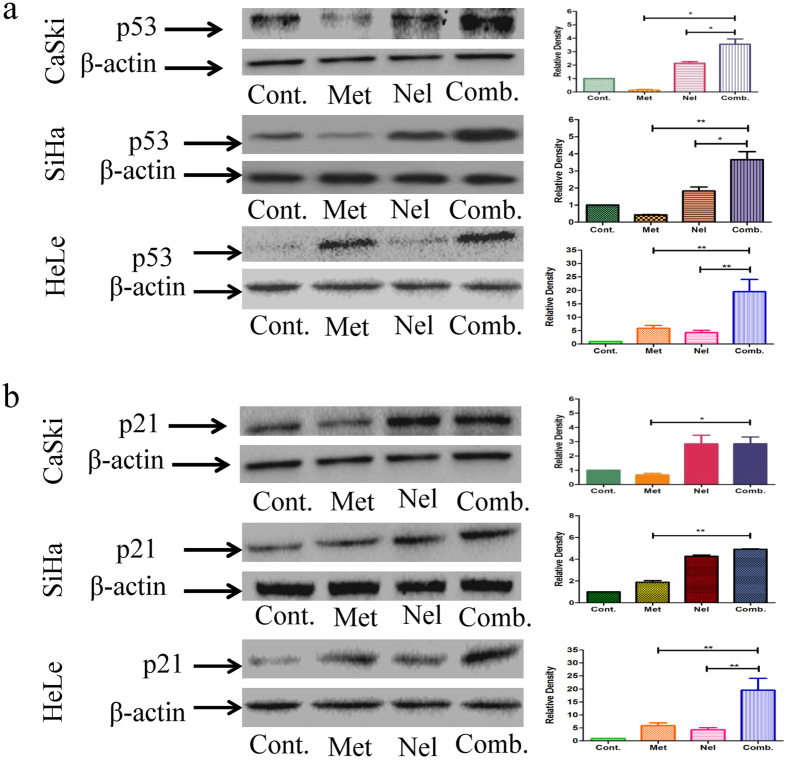
The effects of metformin and nelfinavir, alone or in combination, on cancer-related proteins p53 (a) and p21 (b). SiHa, HeLa and CaSki cells were treated with 10 mM metformin or 4 μM nelfinavir, alone or in combination, for the indicated times. Antibodies against p53 and p21 were used. Each sample was tested in triplicate and data are shown as means ± SEM. Values are expressed as the fold change of untreated control at the indicated time point. *p < 0.05, **p < 0.01, compared to untreated control or individual drug (Cont, control; Met, metformin; Nel, Nelfinavir; Comb, the combination of metformin and nelfinavir).